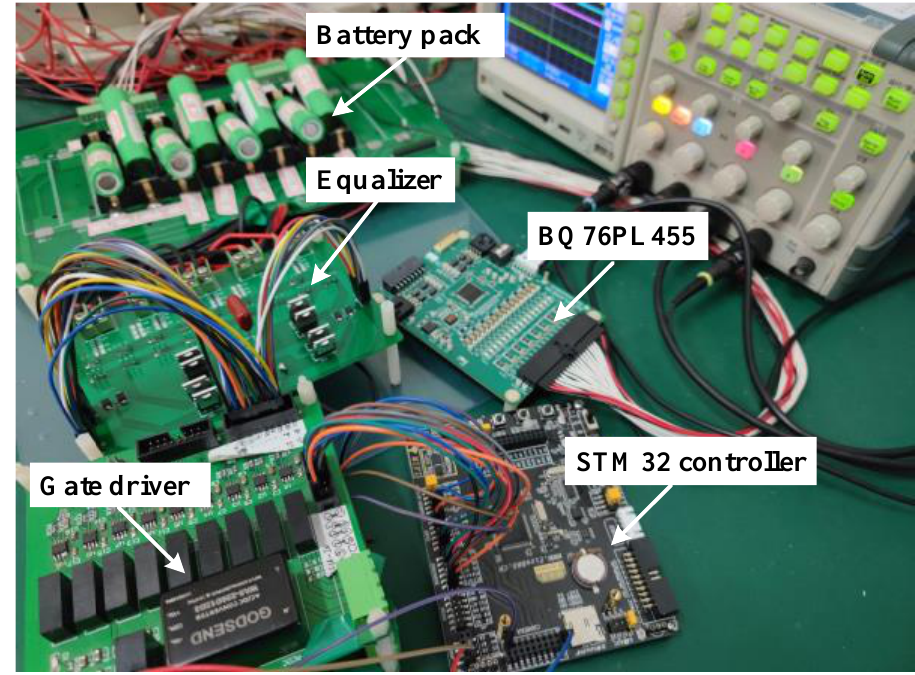
Figure 8. Experimental prototype for eight cells. Table 4. The parameters of the